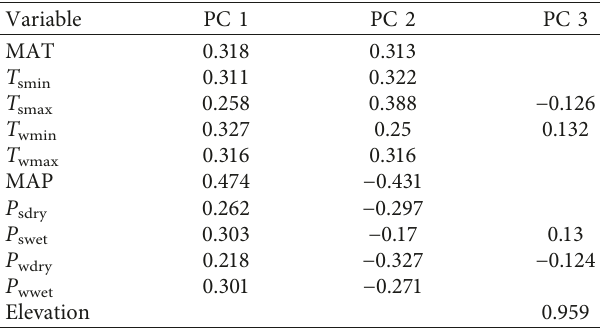
Figure 2: Scree plot showing the eigenvalues for the 11 compo- nents of the data variables. Elbow in the plot can be observed at component 3. Table 1: Loadings of the three principal